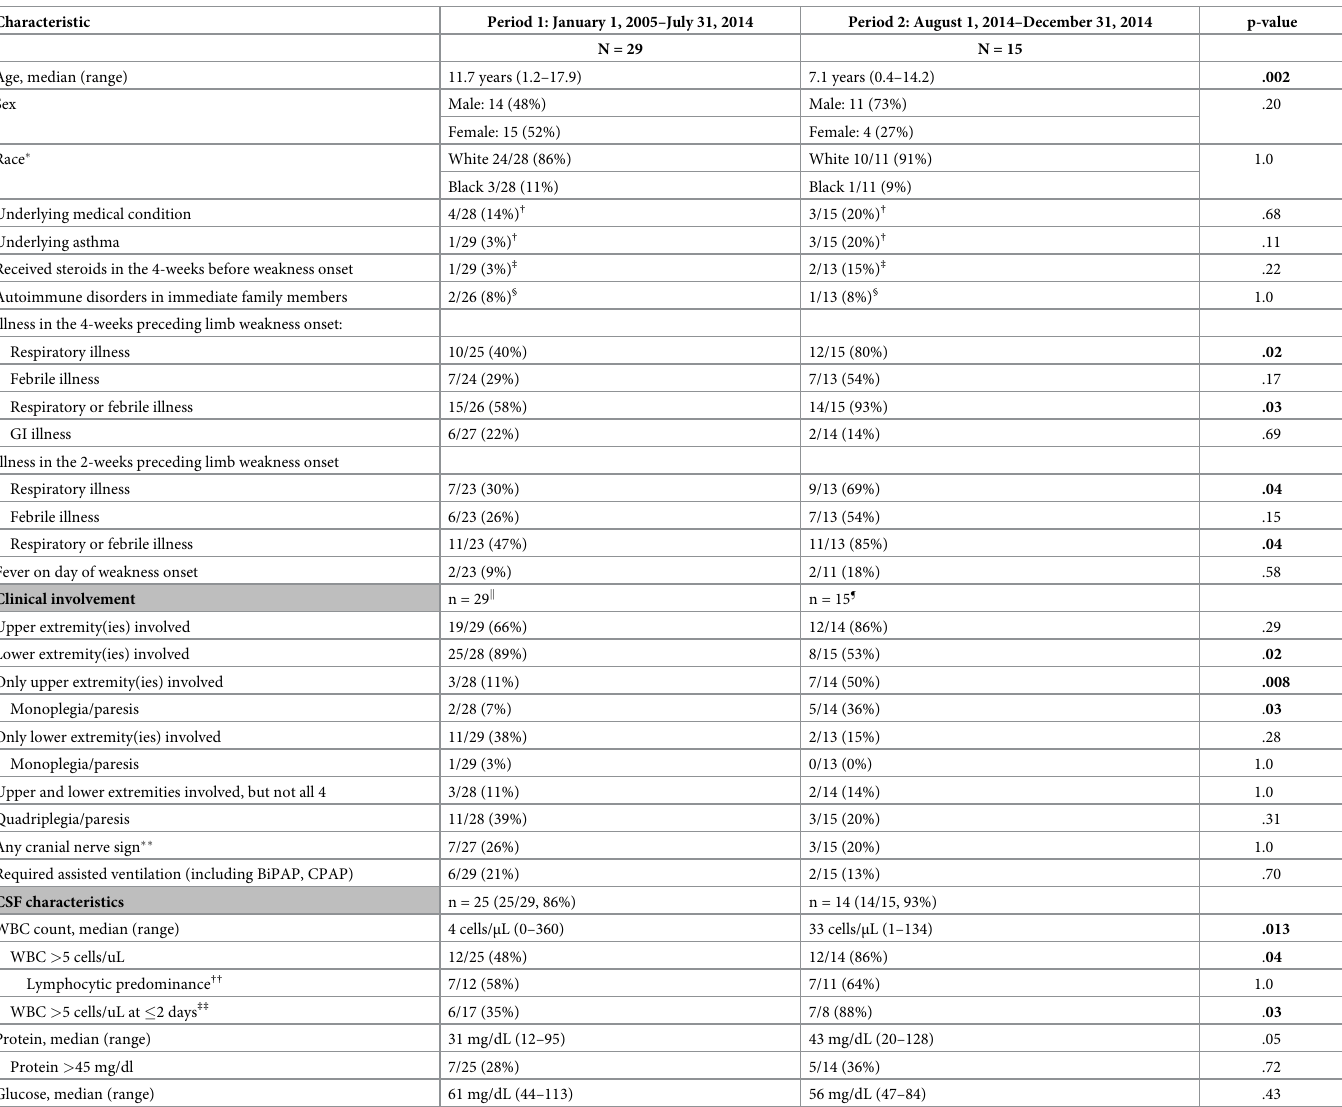
Table 1. Characteristics of AFM cases, by onset